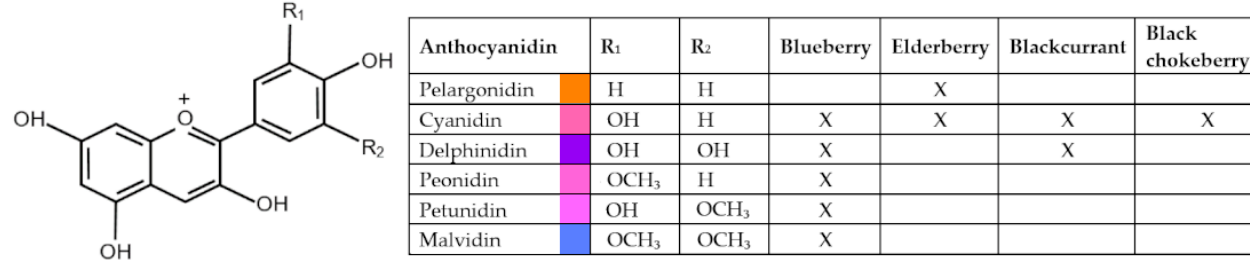
Figure 1. The structural formula of six anthocyanidins commonly synthesized in the fruits that accumulate the most anthocyanins from the Ericaceae, Caprifoliaceae, Grossulariaceae, and Rosaceae families. Adapted from [11]. Highlighted are the colors of each anthocyanidin.